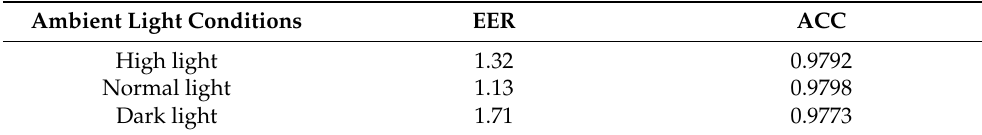
Table 4. Comparison table of results under different ambient